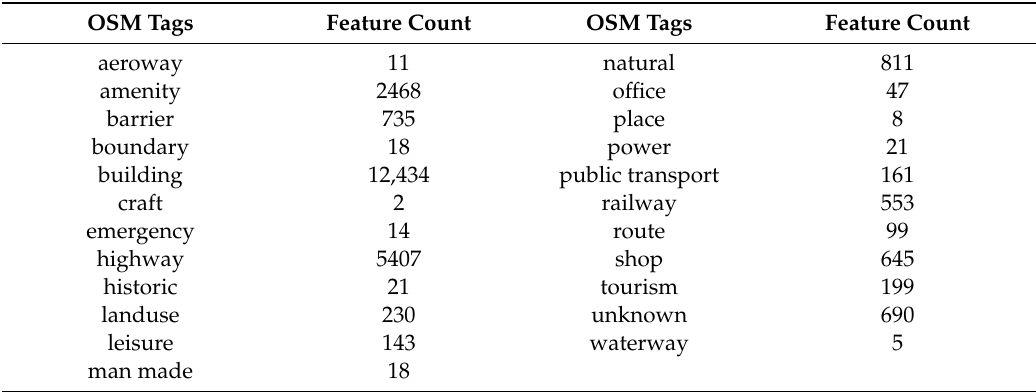
Table 3. OSM tags and feature count in the study